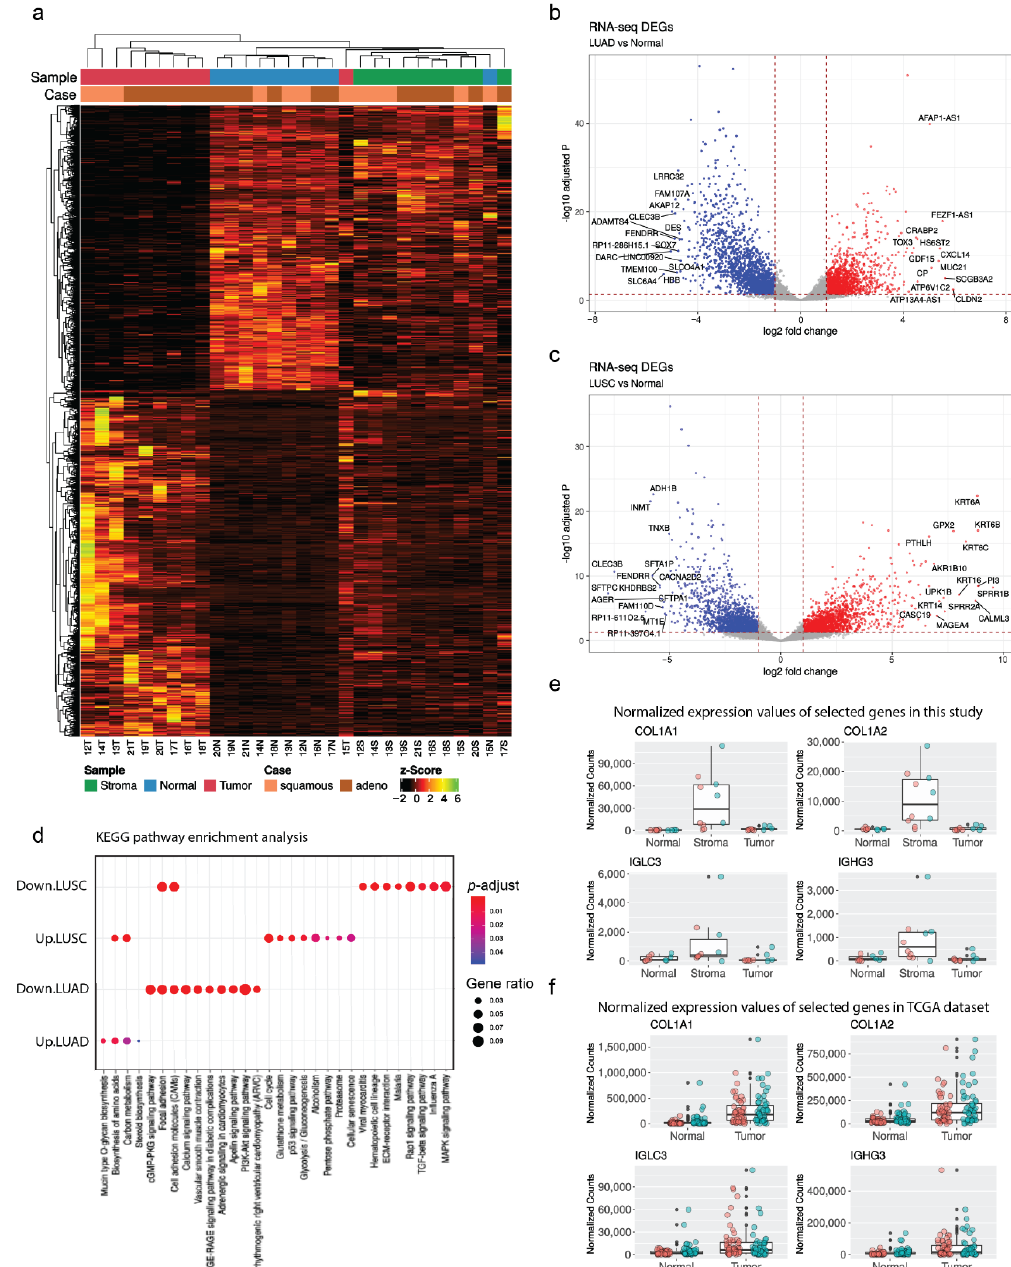
Figure 2. ( a ) Heatmap representation of 4118 genes of 30 samples (10 tumor, T; 10 normal, N; and 10 stroma, S) from 10 cases (Table S4), filtered by FDR-adjusted p -value < 0.01 and absolute fold change ≥ 2. Volcano plot of DEGs between LUAD vs. normal ( b ), and LUSC vs. normal ( c ). With log2 (Fold change) as the x-axis and log10 (adjusted p -value) as the y-axis, the volcano plot was made according to the gene expression level. The red dots indicate upregulated genes, the blue dots indicate downregulated genes, and the grey dots indicate non-significant genes. The top 15 up/downregulated genes (ranked by fold change) highlighted with their gene names. ( d ) KEGG pathway enrichment analysis of significant up/downregulated genes in LUAD and LUSC. The color and size of the dots represent the range of adjusted p -value and the number of DEGs mapped to the indicated pathways, respectively. The top 10 enriched pathways are shown in the figure. Boxplot of mean expression levels for four indicated genes COL1A1 , COL1A2 , IGLC3 , and IGHG3 of: ( e ) this study’s normal samples ( n = 10), stroma samples ( n = 10), and tumor samples ( n = 10); ( f ) TCGA data normal samples ( n = 101), and tumor samples ( n = 101). Individual values are presented as colored circles. Red circles indicate LUAD subtypes, light green circles indicate LUSC subtypes.